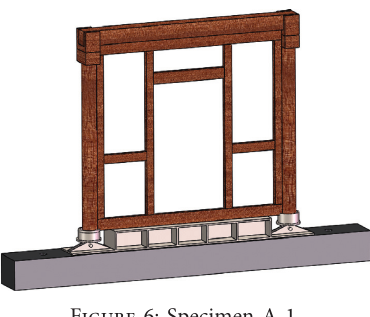
Figure 6: Specimen A-1.